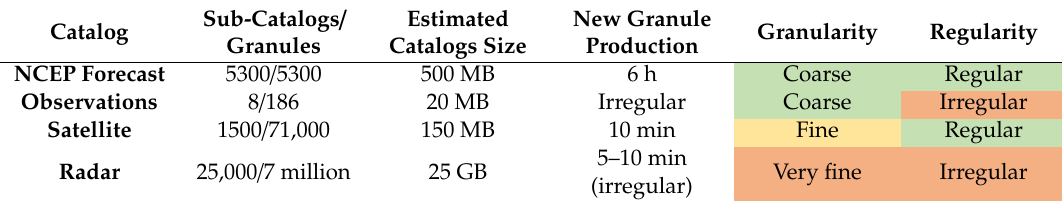
Table 1. Unidata TDS subcatalog big data characteristics.